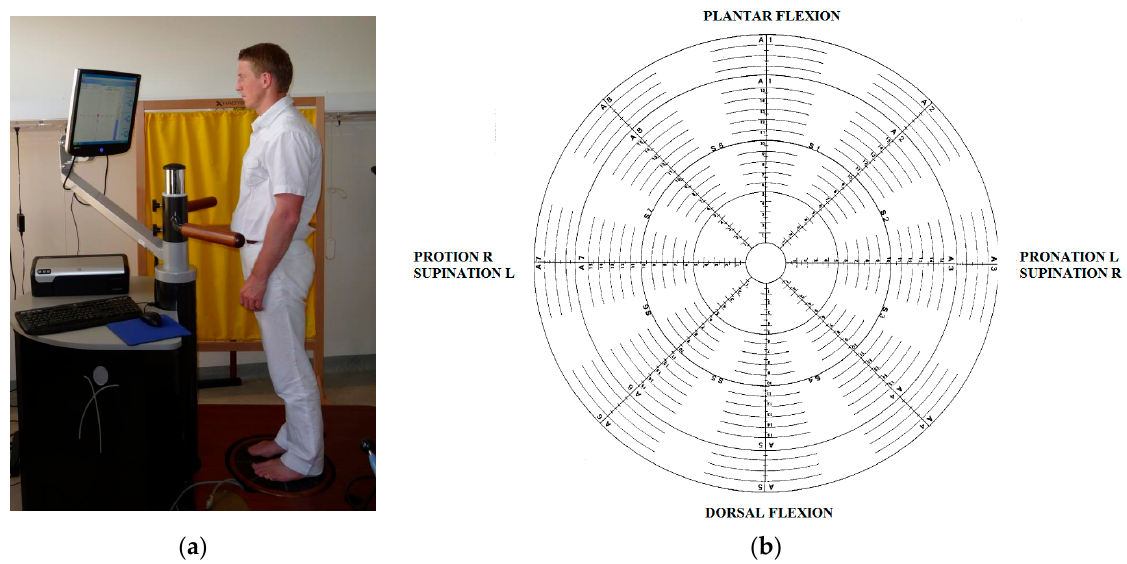
Figure 1. Measurement protocol: ( a ) examination on stabilometric platform; ( b ) TecnoBody PK 254 stabilometric platform structure.